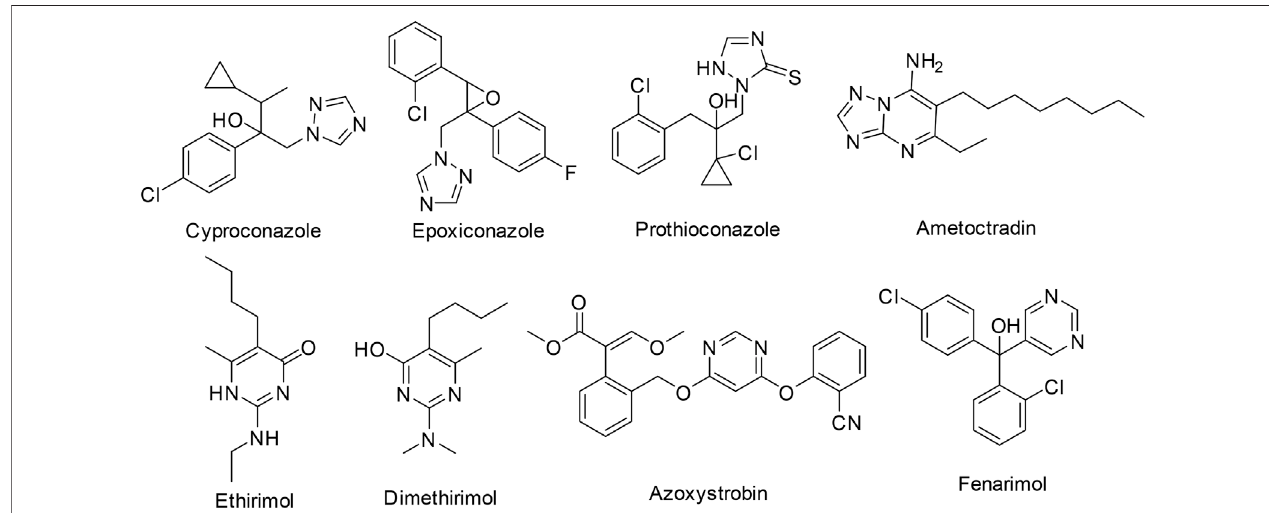
FIGURE 1 | The structure of the sterilizing agent and triamcinolone.